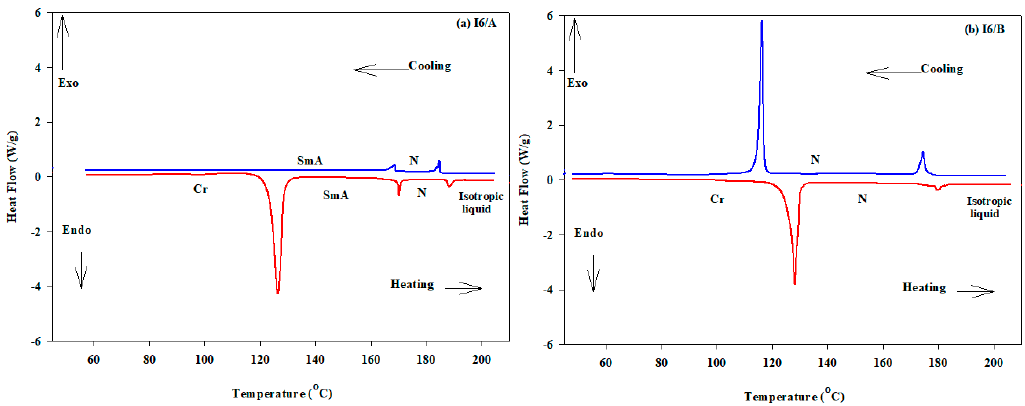
Figure 2. Polarized optical microscopy (POM) textures of the I6/A and I6/B 2:1 SMHB complexes upon heating for: ( a ) the I6/A Smectic A (SmA) phase at 152 ° C, ( b ) N phase at 179 ° C, and ( c ) for I6/B N phase at 175 ° C.